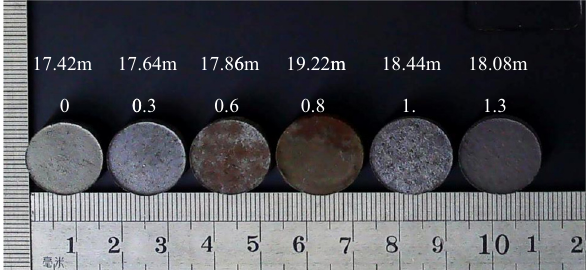
Figure 7: Morphology of reduced briquettes with di ff erent basicity values fi red at 1,230°C and reduction for 60 min.